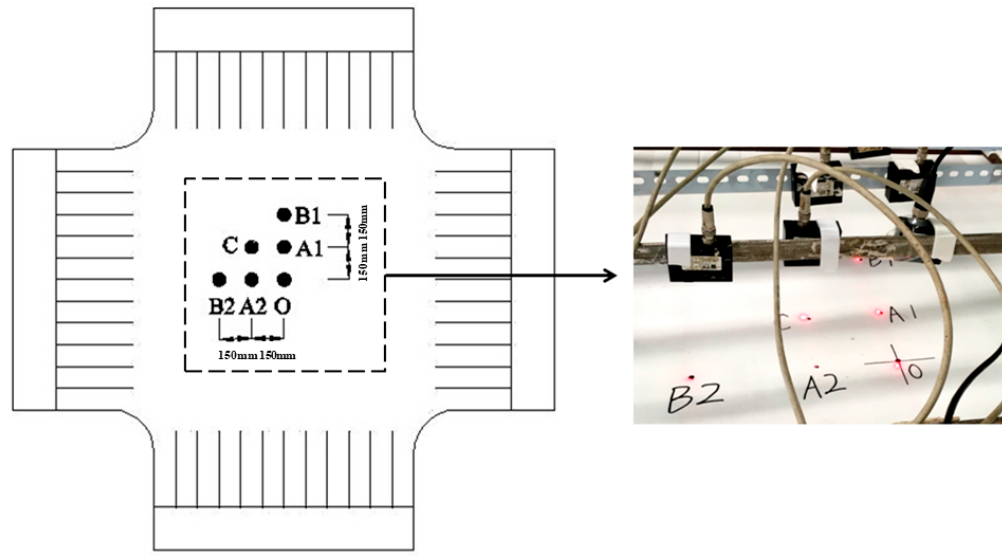
Figure 9. Distribution of measurement points.